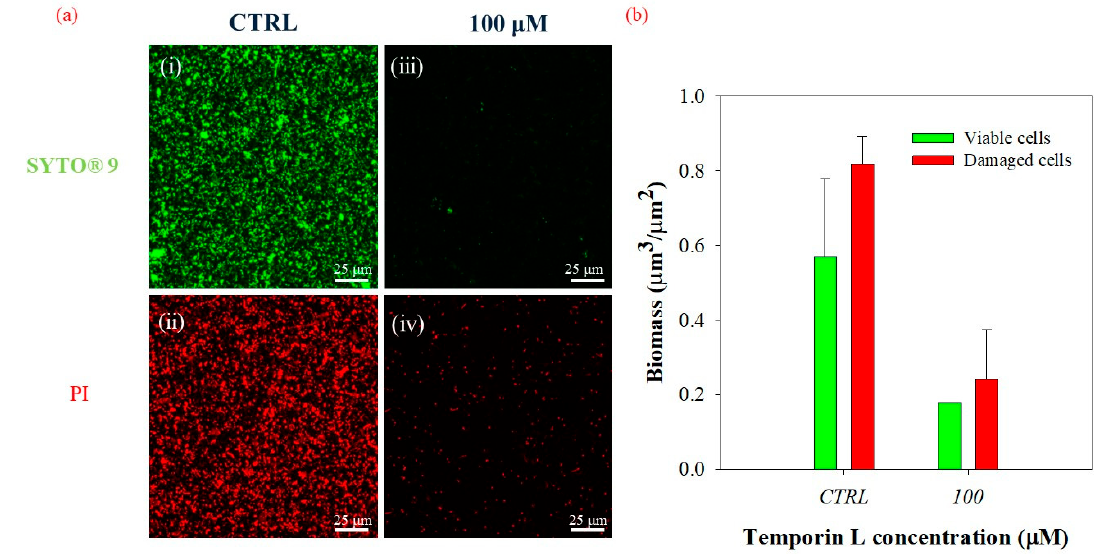
Figure 6. ( a ) CLSM images of biofilms cultivated under in-flow conditions. (I, ii) CTRL (negative control), (iii, iv) TL treated biofilms (iii, iv, 100 μ M), which was dissolved in the nutrient medium and flowed for 24 h. Alive bacterial cells were stained with the green fluorescent dye, SYTO ® 9 (3 μ L/mL), and damage bacterial cells with the red fluorescent dye, Propidium Iodide (PI, 1 μ L/mL); 63X magnification, scale bar: 25 μ m. ( b ) Quantification of alive and damaged biomass in the function of the TL concentration. The alive and dead cells ratio was measured as 0.70 in the control, and 0.74 in the TL treated sample—confirming the antibiofilm activity of the peptide.